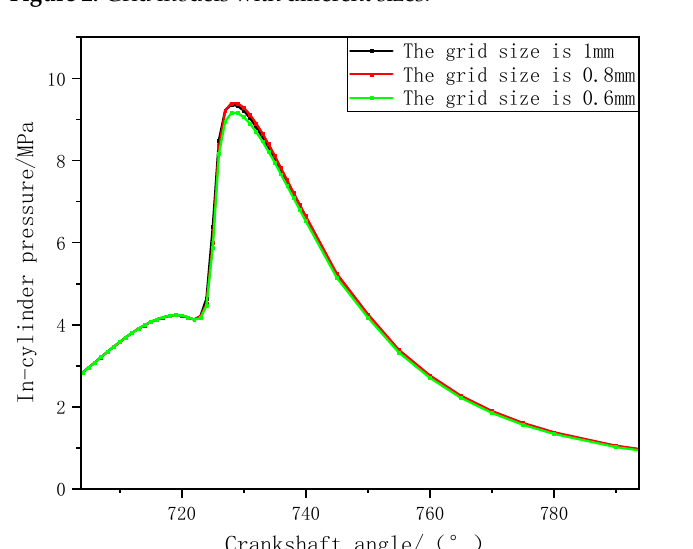
Figure 2. Grid models with different sizes.